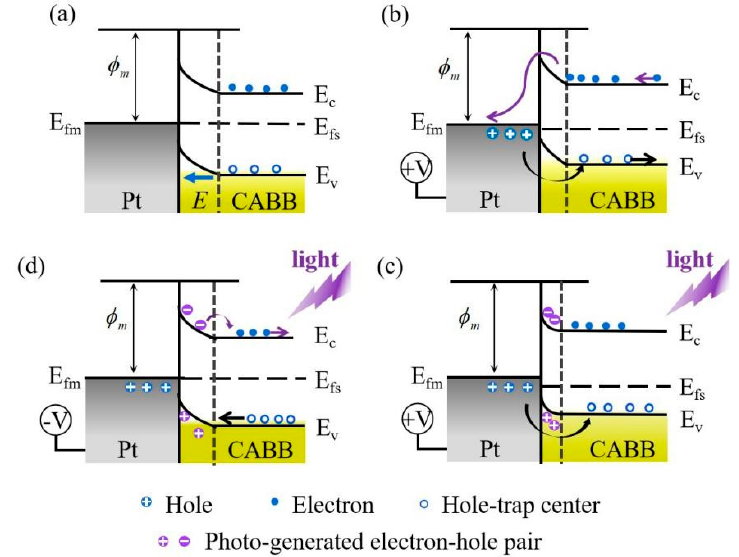
Figure 8. Photo-assisted switching mechanism in the Pt/CABB/ITO/glass device. ( a ) Initial HRS: a Schottky-like barrier generated in the Pt/CABB interface prevents electrons transport between Pt and ITO; ( b ) SET process: vacancies located at the CABB surface are filled, the height and width of the barrier are decreased; ( c ) photo-assisted SET process: holes left by photo-generated electrons intensify the band bending and facilitate electron transport across the thinner barrier in the Pt/CABB interface; ( d ) RESET process: photo-generated electrons move toward the ITO and holes recombine with the trapped electrons in the depletion region, the barrier recovers its original